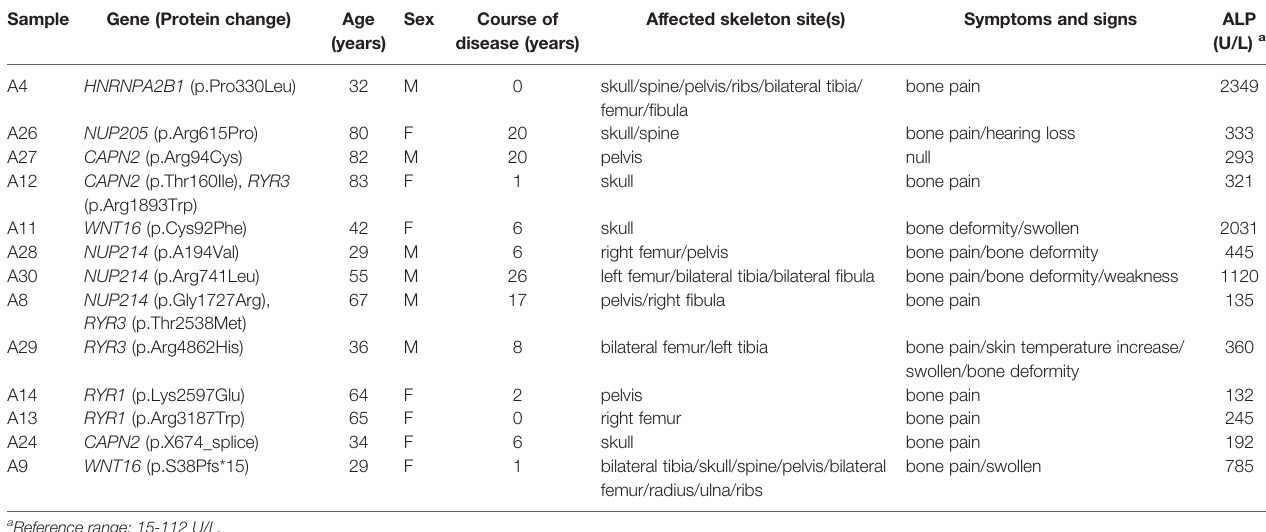
TABLE 7 | Clinical features of the 13 affected individuals with 15 rare variants.